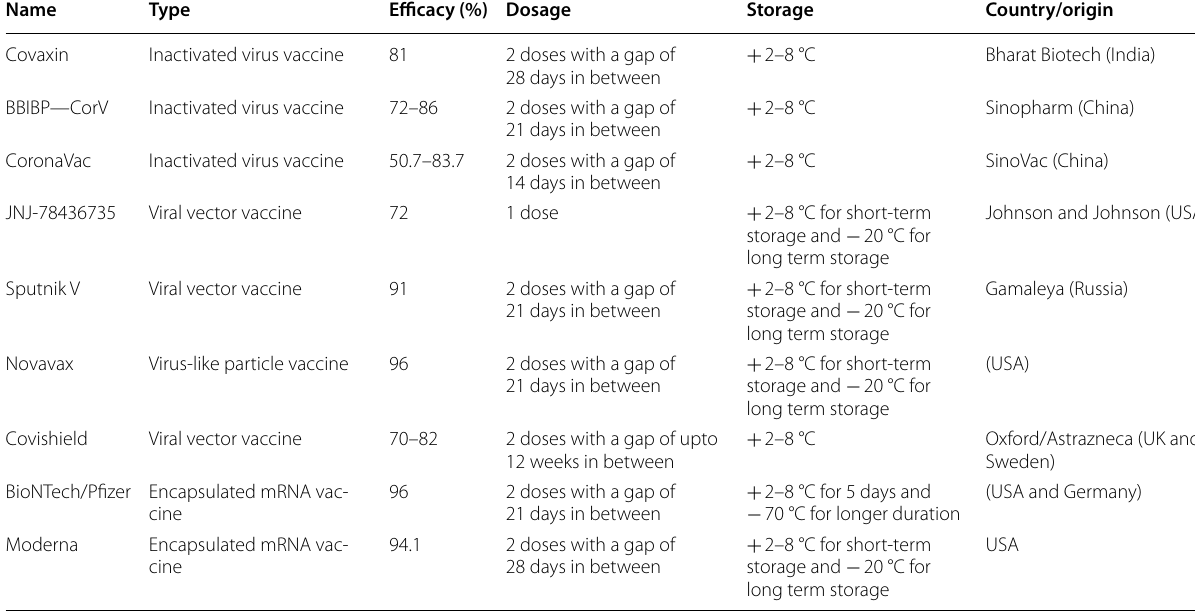
Table 4 Comparative analysis of the currently available vaccines. Sources : The information summarized in the tables were extracted from the reports